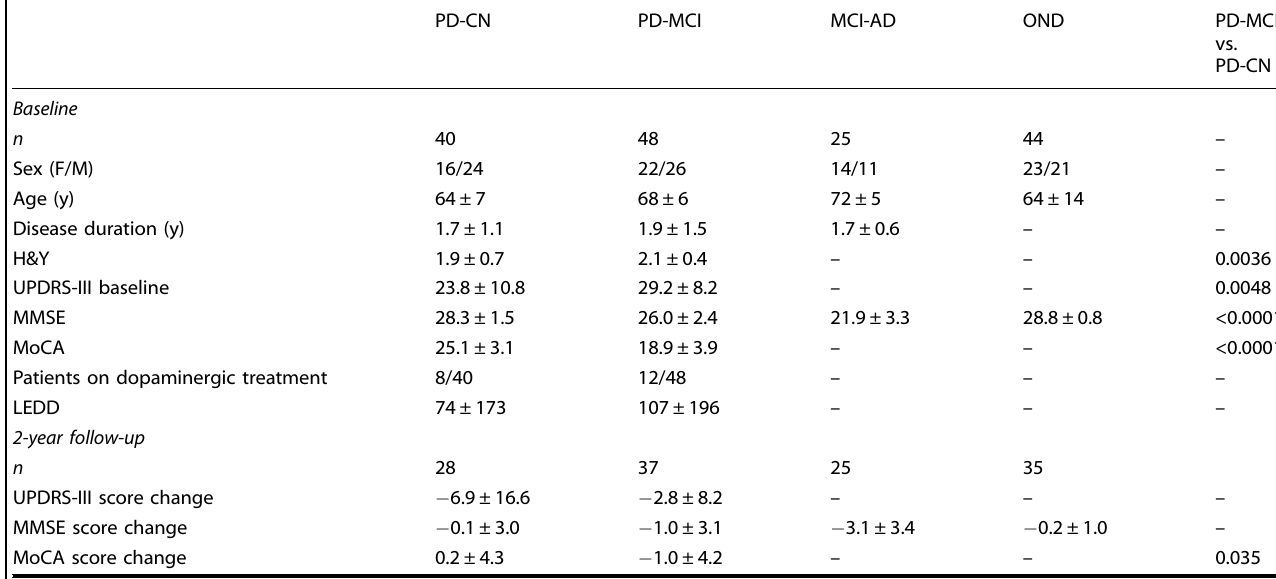
Table 1. Demographic and clinical features in each diagnostic